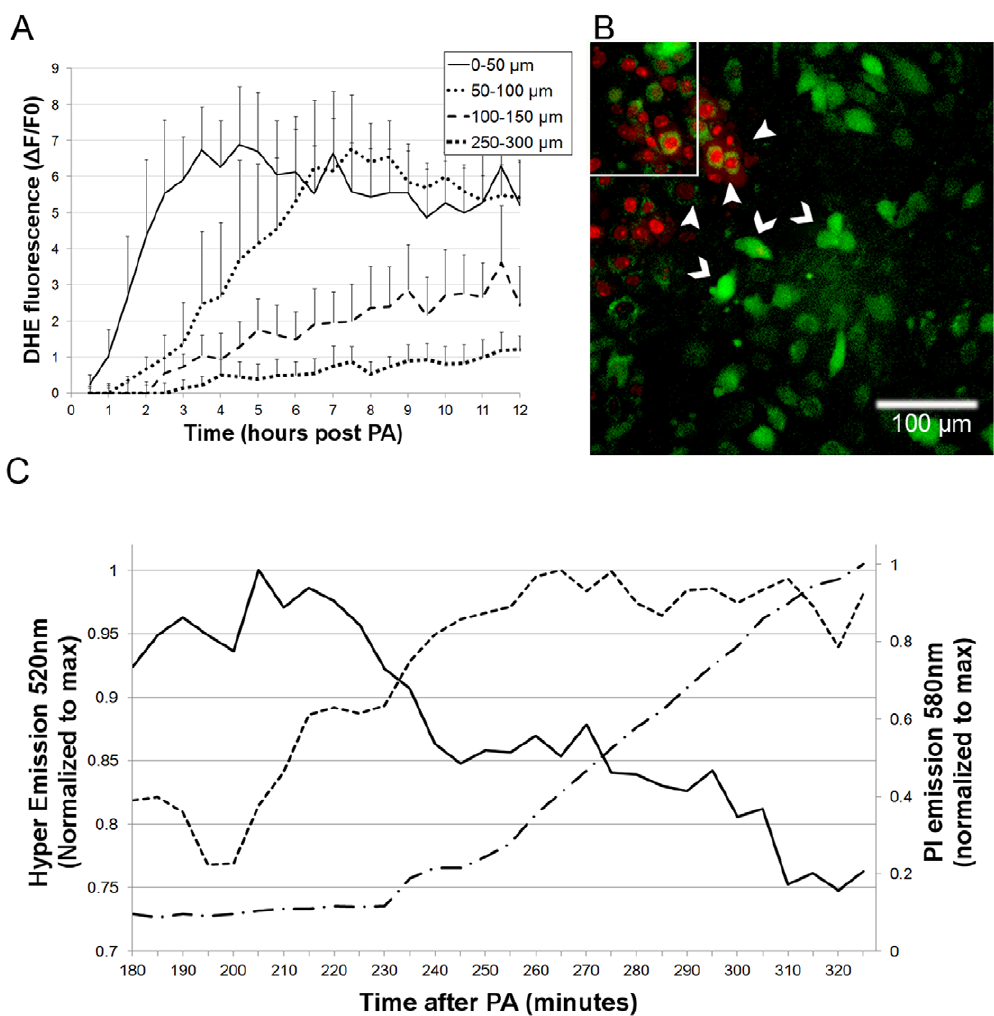
Figure 4. Superoxide anion (O 2 N 2 ) and H 2 O 2 detection in bystander cells following localized oxidative insult. A – Time dependent DHE fluorescence increase (superoxide generation) in bEnd.3 cells at four selected distances from the COI boundary, within the monolayers (n=10 cells, 6 SD). B, C – H5V-Hyper monolayers supplemented with PI and 100UI/ml catalase, were subjected to COI and imaged. B – An overlay of Hyper protein fluorescence (H 2 O 2 elevation, intense green, 520nm emission, chevrons) and PI + (red, at a distant of 30–40 m m from the white rectangle COI rim, arrowheads) emissions acquired 3h after the COI. C – Time dependent fluorescence intensity of Hyper-low (solid line), Hyper-high (dashed line) and PI (dashed dotted line) levels, in a single bystander H5V-Hyper cell adjacent to PI positive cells that were normalized to maximum. The Hyper low fluorescence decreased by 20%, while the Hyper-high emission elevated within 90 minutes by ,